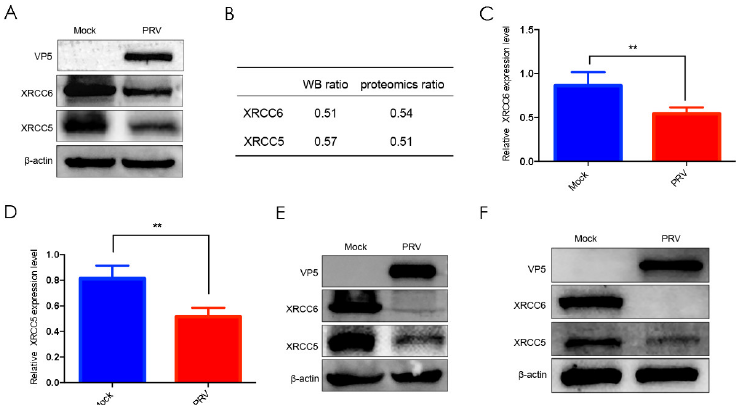
Figure 3. Validation of proteomics data by western blot and RT-qPCR. ( A ) Vero cells infected with PRV for 24 h were collected and western blot was performed to detect the expression of XRCC5 and XRCC6 with corresponding antibodies. ( B ) The western blot and proteomics ratio of XRCC5 and XRCC6. ( C ) Relative XRCC6 transcription in Vero cells. ( D ) Relative XRCC5 transcription in Vero cells. ( E ) The expression of XRCC5 and XRCC6 in PK-15 infected with PRV. ( F ) The expression of XRCC5 and XRCC6 in CRL-2843 infected with PRV. ** indicates significance at a 99% confidence interval ( p < 0.01)